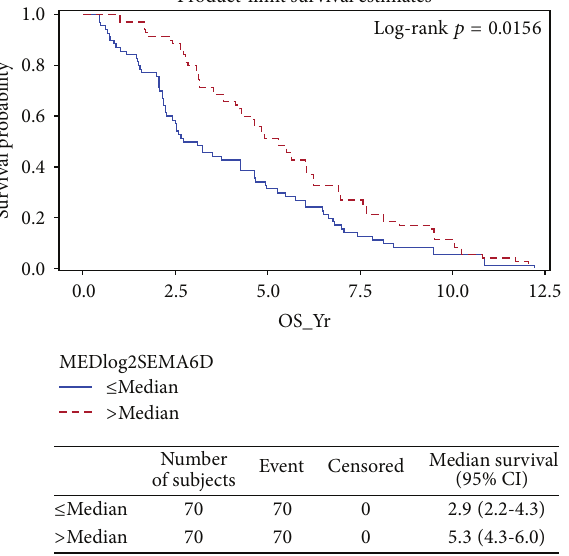
Table 4: Correlation of SEMA6D with EMT gene expressions.